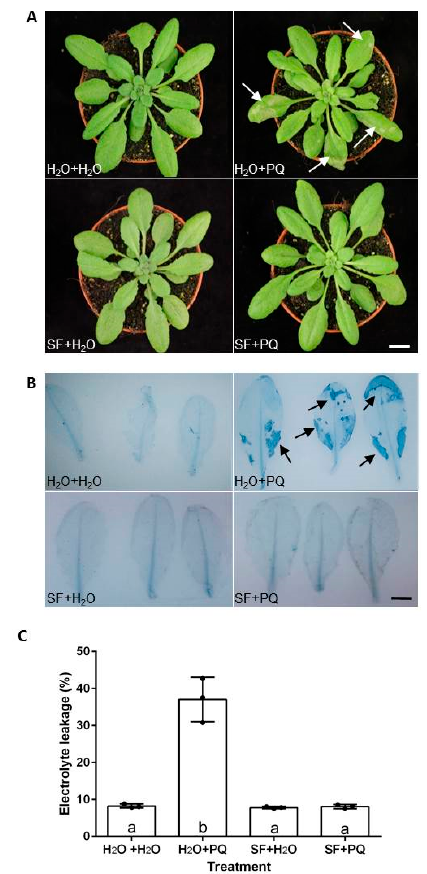
Figure 1. Arabidopsis tolerates oxidative stress upon SuperFifty (SF) priming. ( A ) Rosette phenotype of four-week-old plants pretreated and treated, respectively, with H 2 O and H 2 O (unprimed and unstressed), H 2 O and PQ (paraquat; oxidatively stressed), SF and H 2 O (SF-primed, but unstressed), and SF and PQ (SF-primed and oxidatively stressed); for details, see Materials and Methods. ( B ) Trypan blue stained leaves of the plants from panel ( A ). Blue-stained regions (arrows) of leaves in the